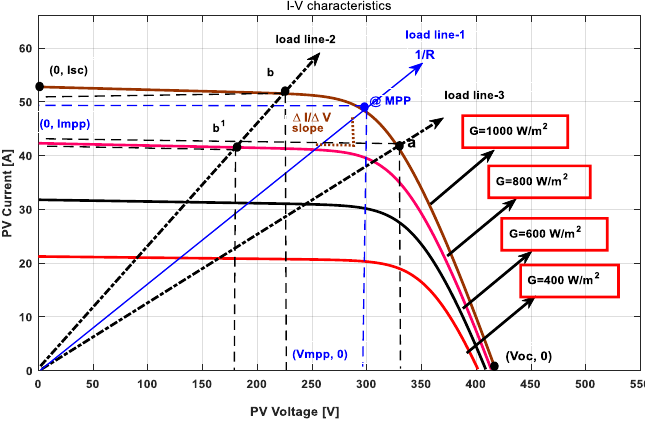
Figure 6. I-V curve of a PV system at different resistive load conditions.